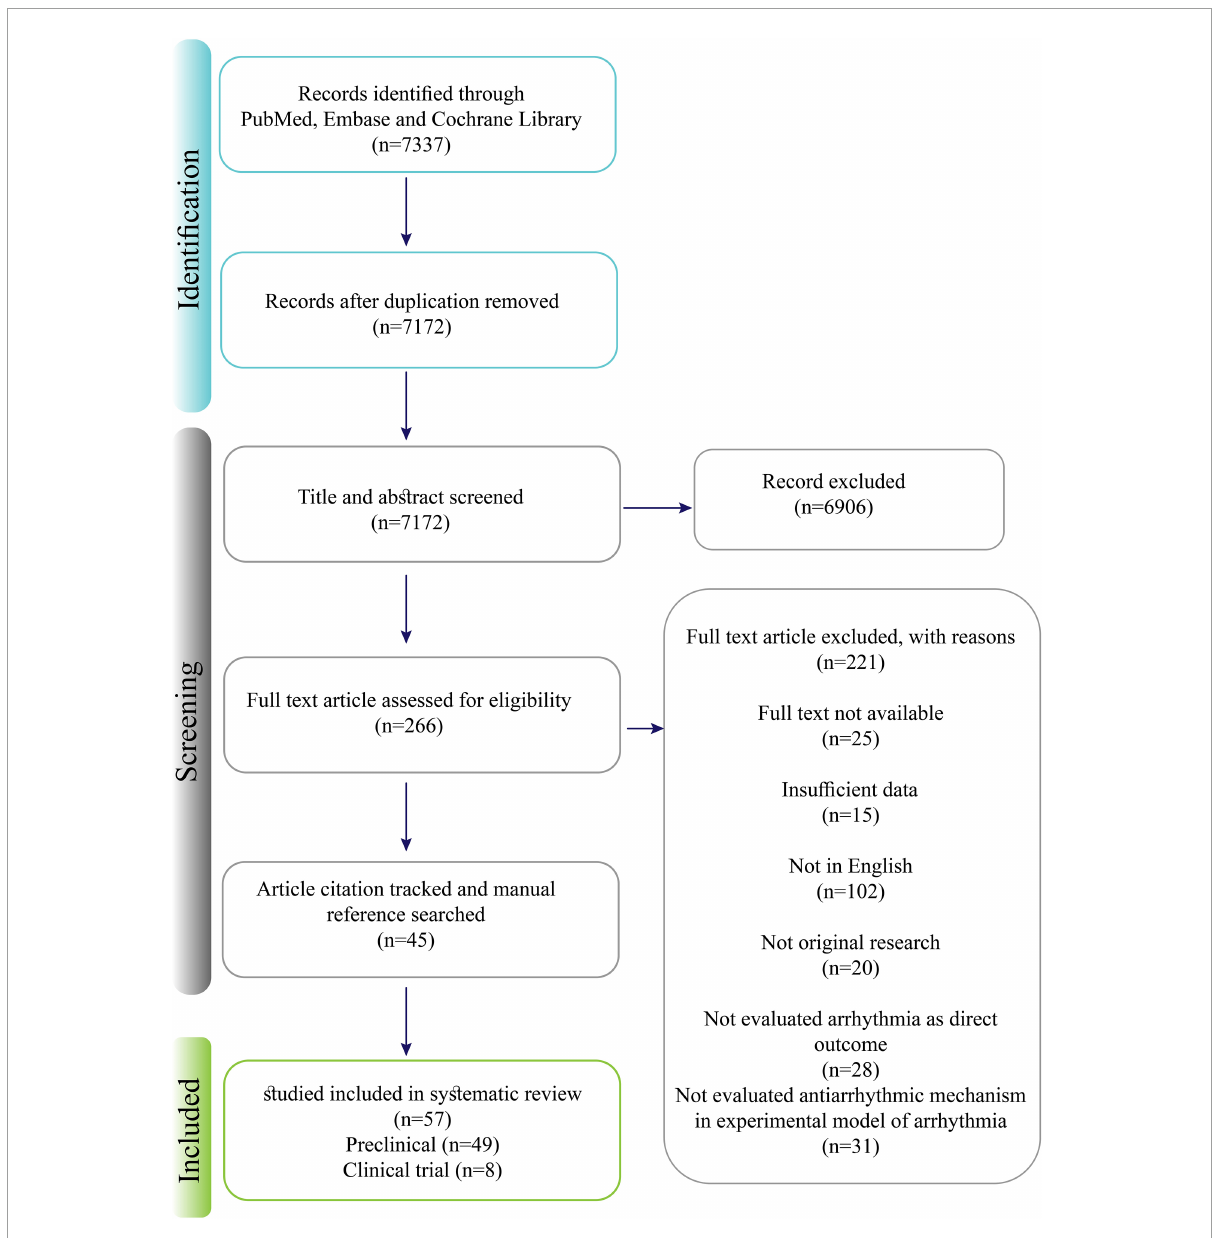
FIGURE1 Prisma chart of the manuscript selection